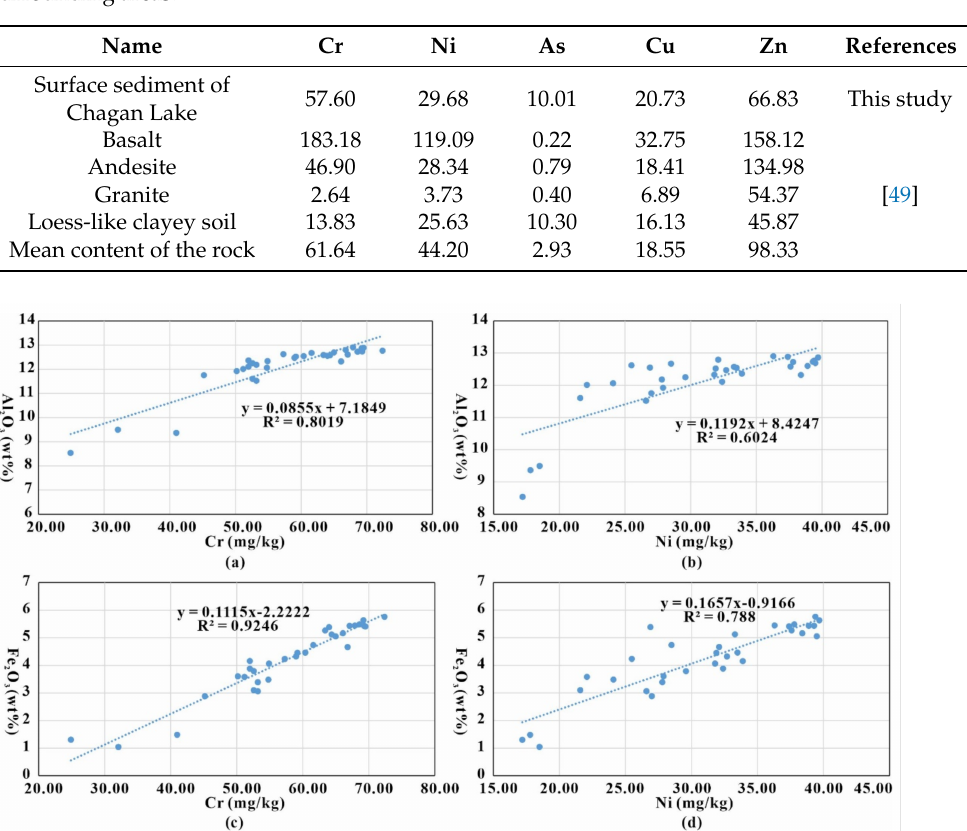
Figure 7. Distribution diagram of Cr and Ni (mg/kg) versus Al 2 O 3 and Fe 2 O 3 (wt %) in the sediments of Chagan Lake. ( a ) Cr versus Al 2 O 3, ( b ) Ni versus Al 2 O 3, ( c ) Cr versus Fe 2 O 3, ( d ) Ni versus Fe 2 O